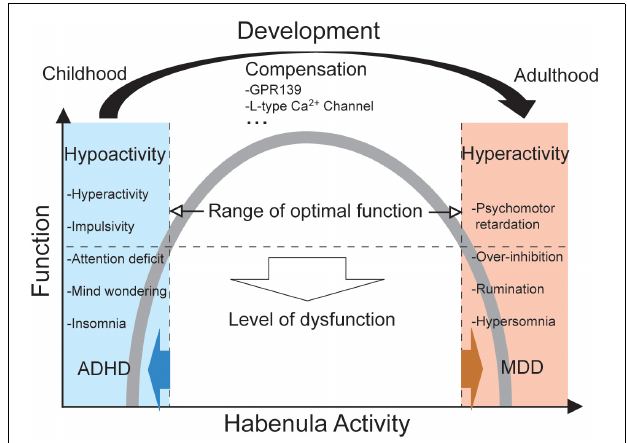
FIGURE 1 | A diagram illustrating the hypothesis. In terms of habenular function in relation to its activity (i.e., an inverted U-shaped relationship), ADHD and MDD may be antithetical. A dysfunctional level of hypoactivity in the habenula may induce an assortment of symptoms relevant to ADHD, whereas hyperactivity of the habenula may cause those relevant to MDD. A transition from hypoactivity to hyperactivity, but not vice versa, may take place over the course of brain development from childhood to adulthood, as compensation. Such a process may involve several molecules, such as GPR139 and L-type calcium